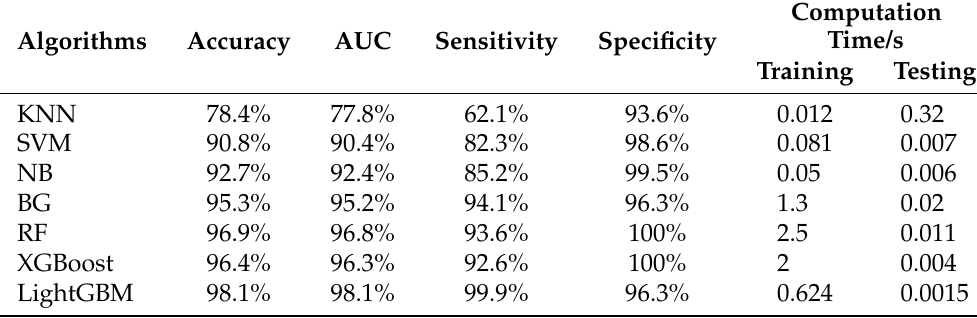
Table 5. Summary of experimental results and computational time on